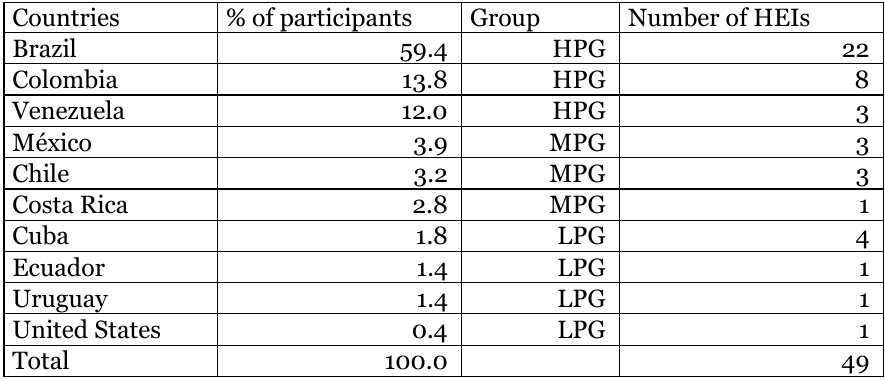
Participants and Higher Education Institutions (HEIs) Per Country